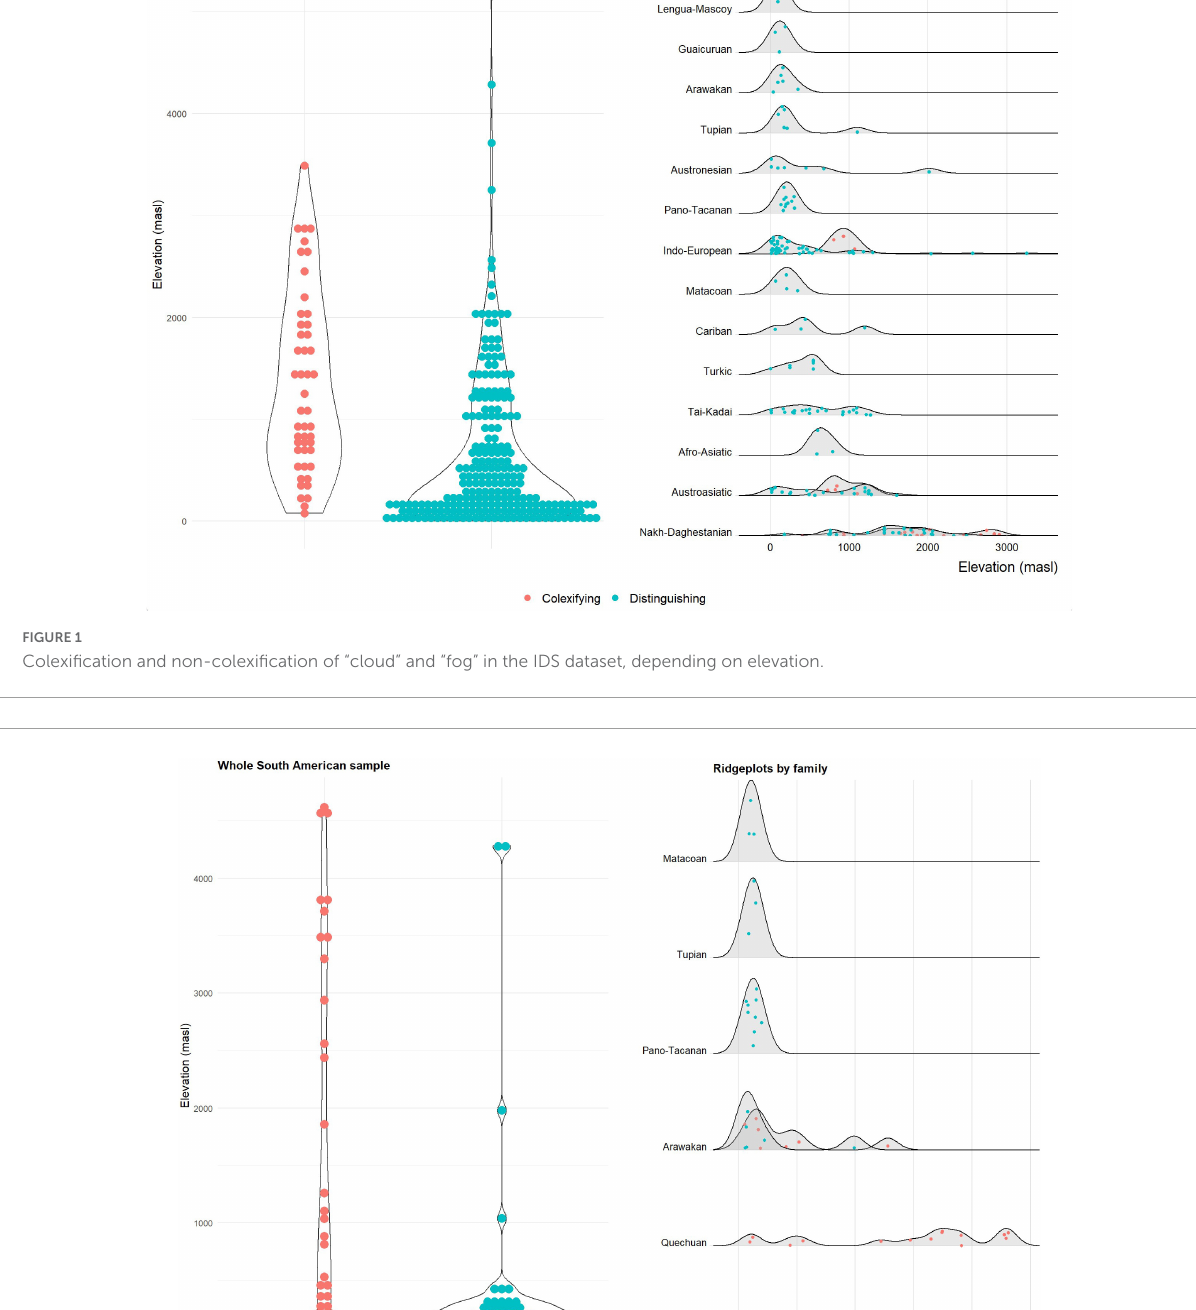
that avoids this issue (refer to, e.g., Janssen et al., 2007). To this end, 10,000 samples were drawn from the full Andean dataset so that each language family that is represented by more than